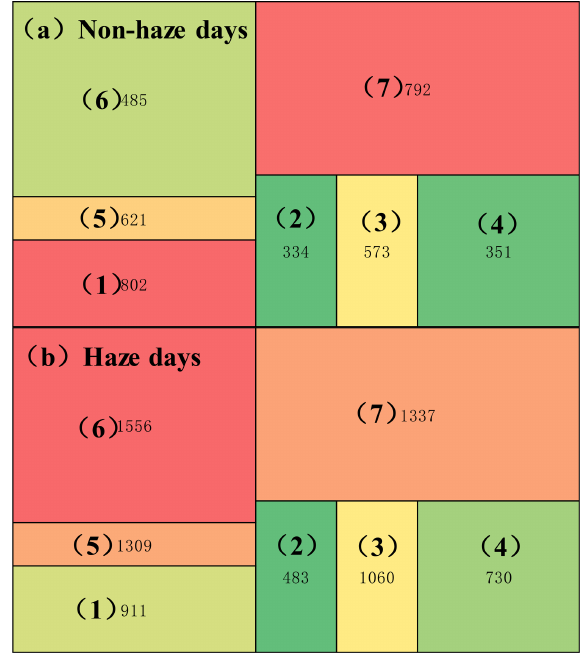
Figure 6. The concentration (ngm − 3 ) sum of identified and un- known organic compounds in each chromatogram image section during (a) non-haze and (b) haze